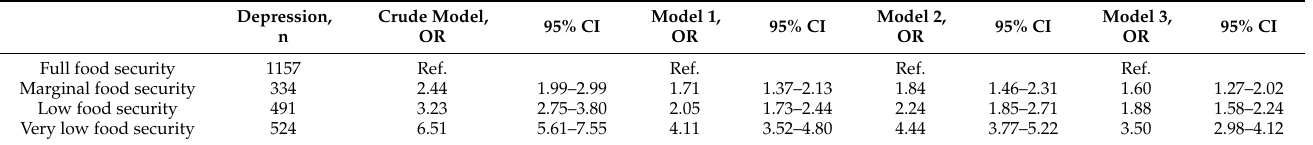
Table 2. Odds of having depression by food security status.